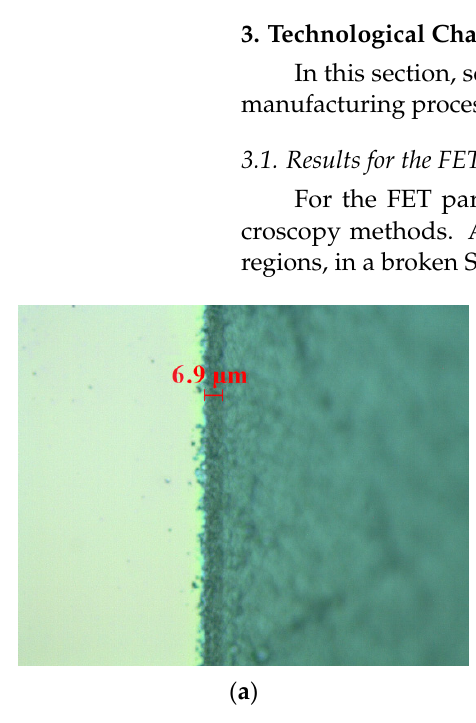
Figure 4. ( a ) Depth of the guard ring (p + -well) of 6.9 μ m and ( b ) n + -well of 2.4- μ m depth (light gray area).